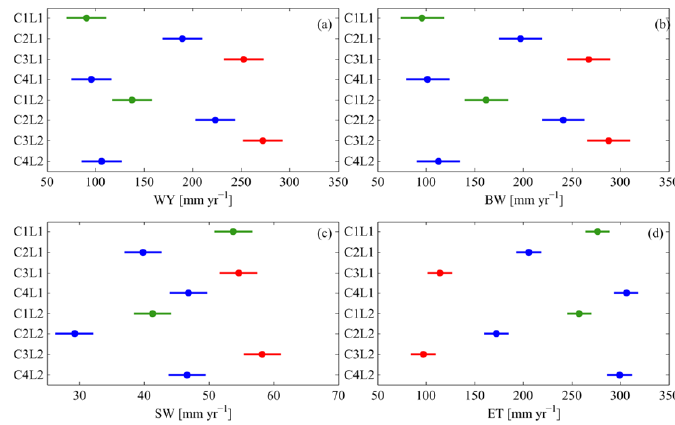
Figure 4. Range of four water resources components. ( a ) WY = water yield; ( b ) BW = blue water; ( c ) SW = soil water; ( d ) ET = evapotranspiration obtained from eight calibrated models. C represents a climate data set, and L represents a land-use dataset. (Source: Kamali et al.